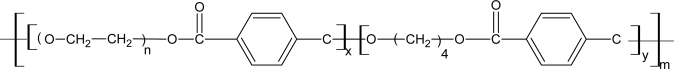
Structure of PolyActive® [23].